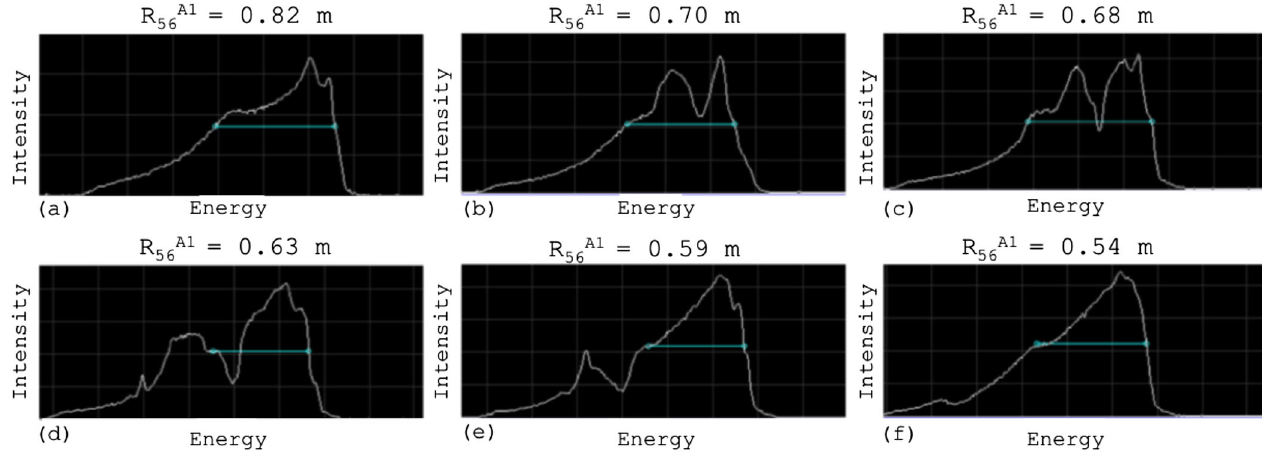
FIG. 4. Measurements of the energy spectrum collected in the second Bates arc. The vertical axis is the population (arbitrary units) and the horizontal axis is the energy (arbitrary units). As the compression is changed, a distinct spike and depletion region form and shift along the spectrum, shown from (a) to (f), as the result of